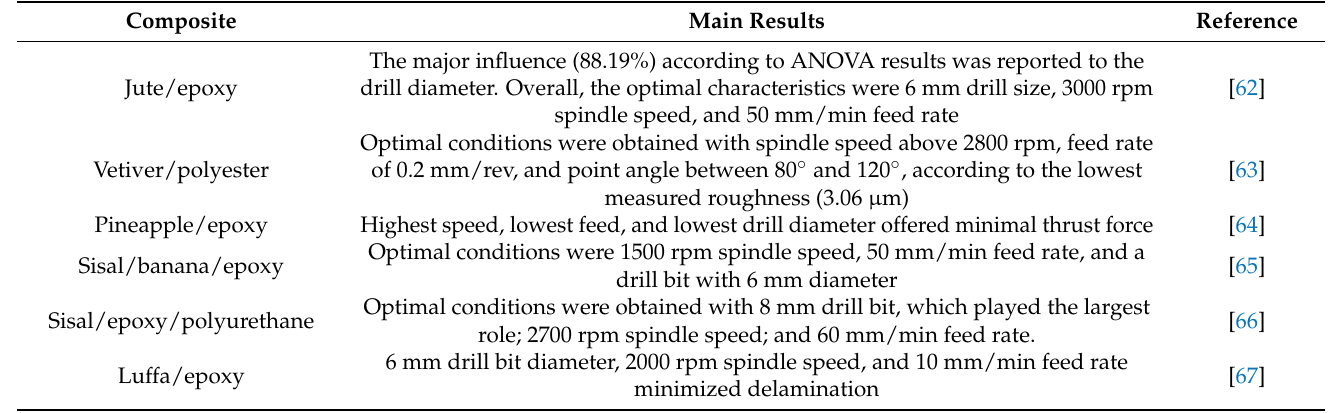
Table 1. Some studies on drilling into natural fiber composites and relevant hole quality